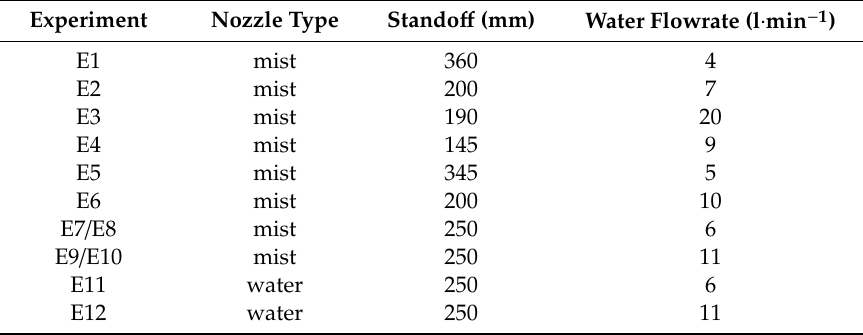
Table 1. List of